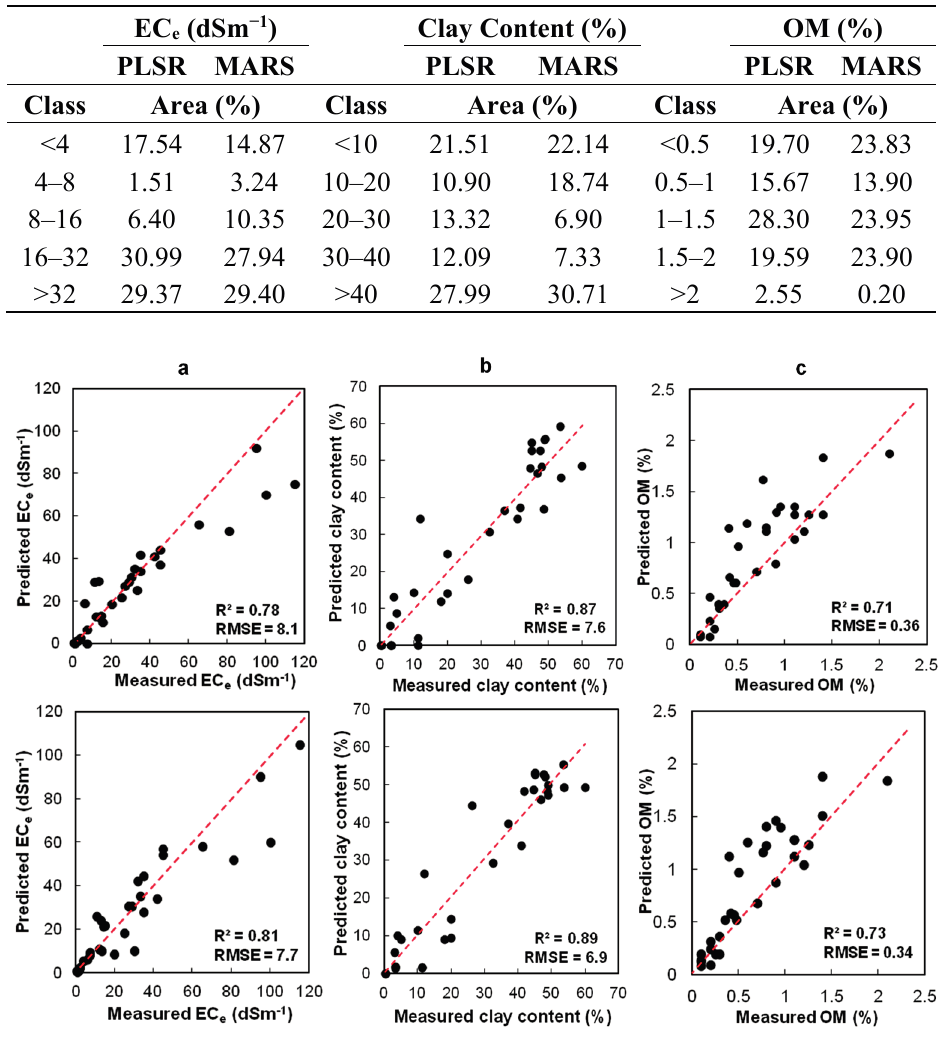
Figure 8. Scatterplots of measured vs. extracted values from PLSR (top) and MARS maps (bottom) for: ( a) EC e ; ( b) clay content; and ( c)